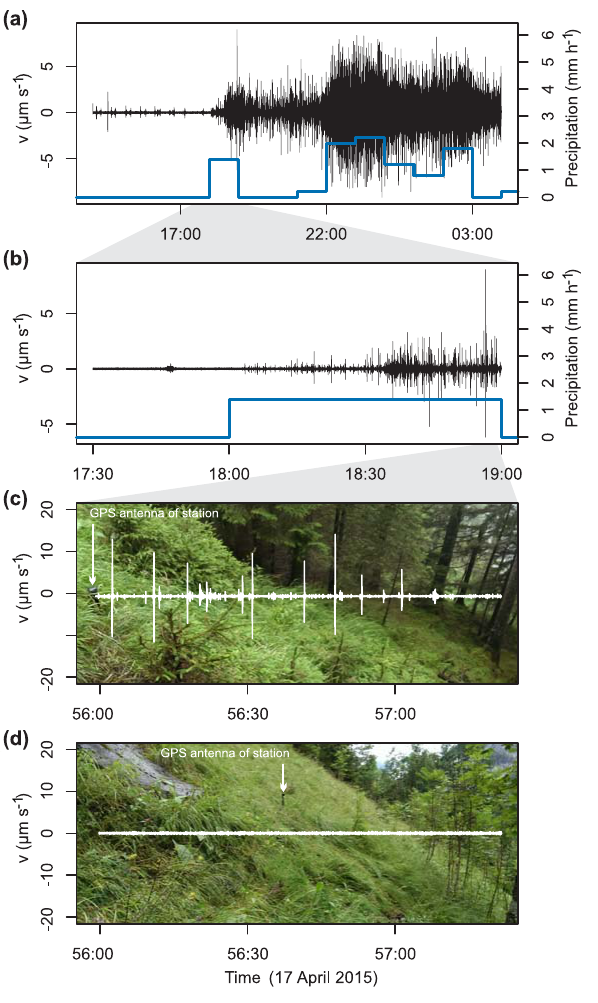
Figure 6. Seismic signal characteristics during a gentle rain event without windy conditions (hourly meteorological data from Meteo- media station in Mürren). Panels (a) to (c) show the vertical compo- nent signal (filtered between 1 and 90Hz) of station “Basejumper’s Mess”. Panel (d) shows the same time interval as (c) but for station “Funny Rain”. Background images of (c) and (d) show the deploy- ment situation of the two stations under a dense coniferous forest cover and on grass land, respectively. Note overall increase in seis- mic signal amplitudes during the rain event and short irregular sig- nal pulses only under forest cover, interpreted as impacts of large drops collected and amalgamated by the trees. Trees continue to release drops even after the precipitation record shows no further atmospheric rain input (a) .